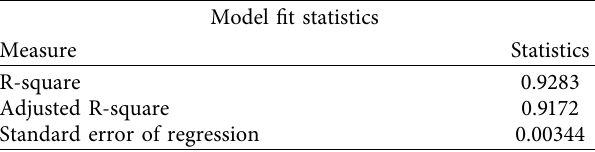
Table 5: Multiple regression analysis